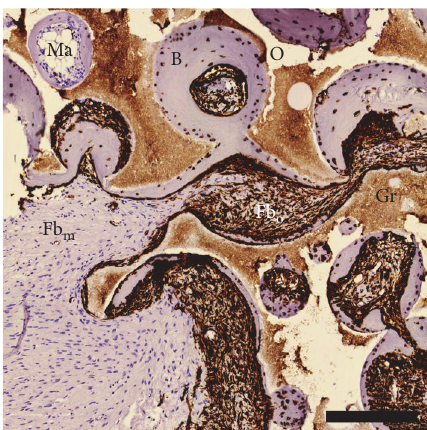
Figure 4: HVIM stain. Tissue stained positive is of ovine origin. All bone tissue in all samples is associated with HVIM+ cells. Fibrous tissue is either HVIM+ or HVIM − . B: bone; Gr: residual granules; Fb m : murine fibrous tissue; Fb o : ovine fibrous tissue; Ma: bone marrow; O: other. Scalebar: 250 𝜇